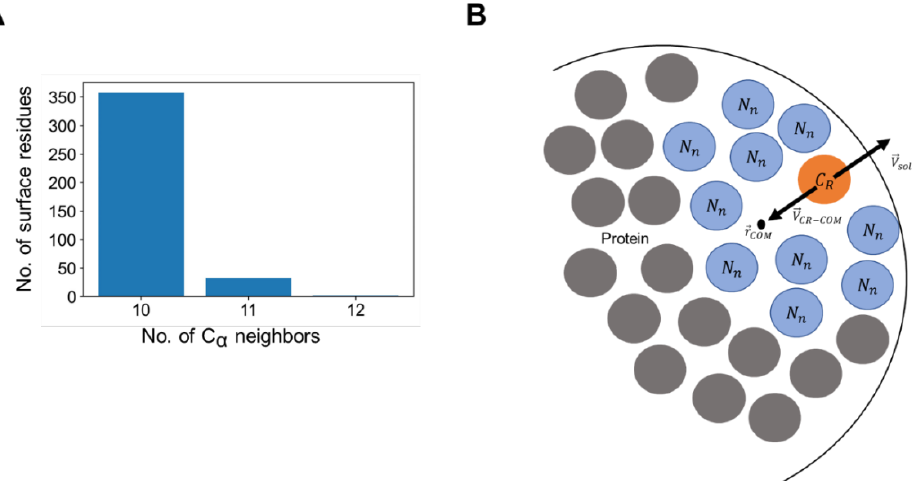
Figure A3. ( A ) Using the MDAnalysis Neighbor Search Wrapper with a search radius of 10 Å, the number of surface residues with 10, 11, or 12 C α atom neighbors, for ID2S, was calculated and plotted. ( B ) Schematic showing the determination of a solvent vector ( V ⃗⃗ sol ) for each surface residue. Each sphere represents a C α atom of a surface residues. C R is the central surface residue whose solvent vector is being calculated and N n is the n nearest atom neighbor. r COM is the location of the center of mass of the n nearest neighbors and V ⃗⃗ CR-COM is the vector used to define.